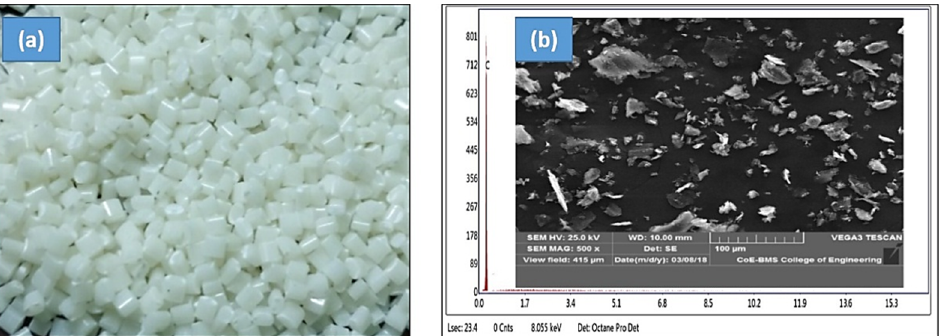
Figure 1. ( a ) Photograph of as received ABS pellets as initial material for twin screw extrusion and ( b ) scanning electron micrograph and EDAX spectrum of as received graphite powder showing the morphology and composition.